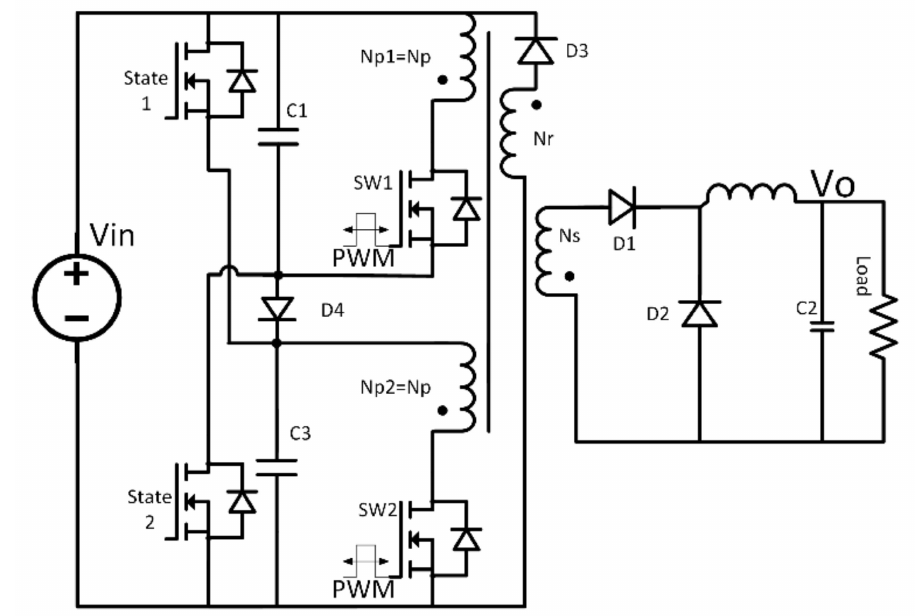
Figure 2. Proposed dual voltage forward converter